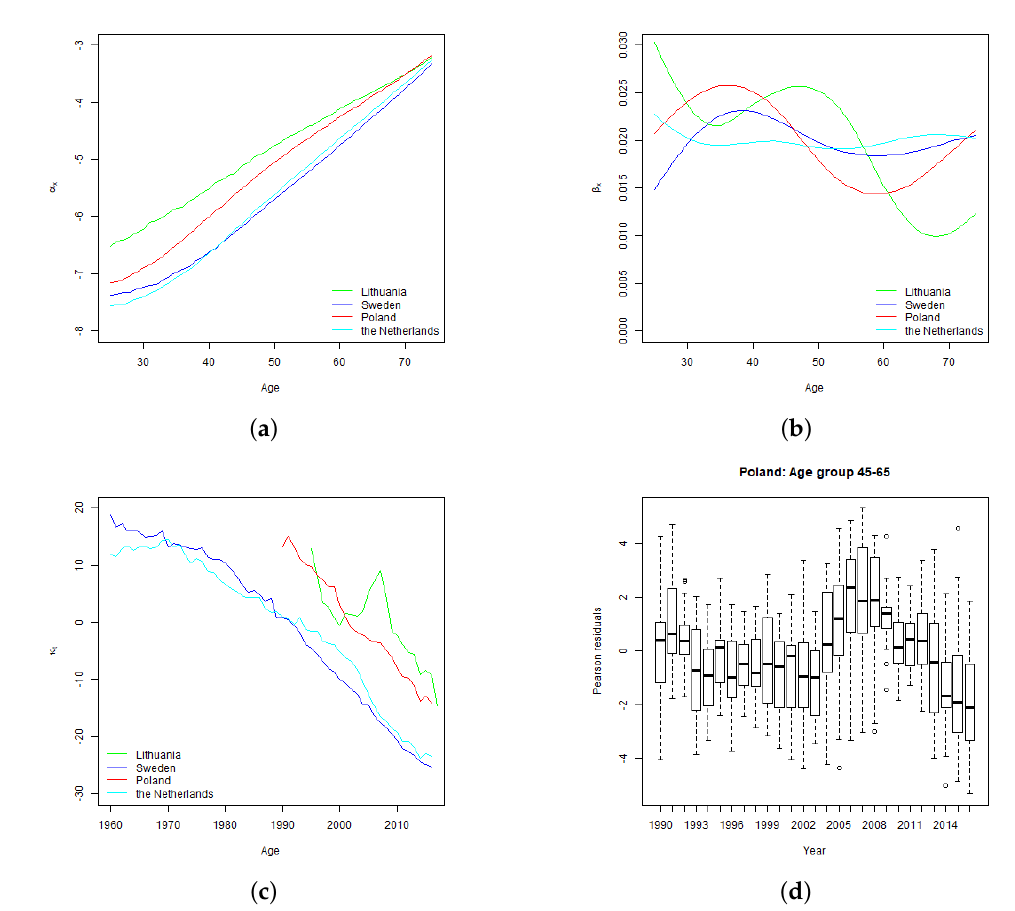
Figure 8. Lee-Carter model parameters α x (panel ( a )), β x (panel ( b )) and κ ( t ) (panel ( c )) estimated using Poisson regression (with re-fitting). Panel ( d ) shows distribution of Pearson residuals for ages 45–65 in